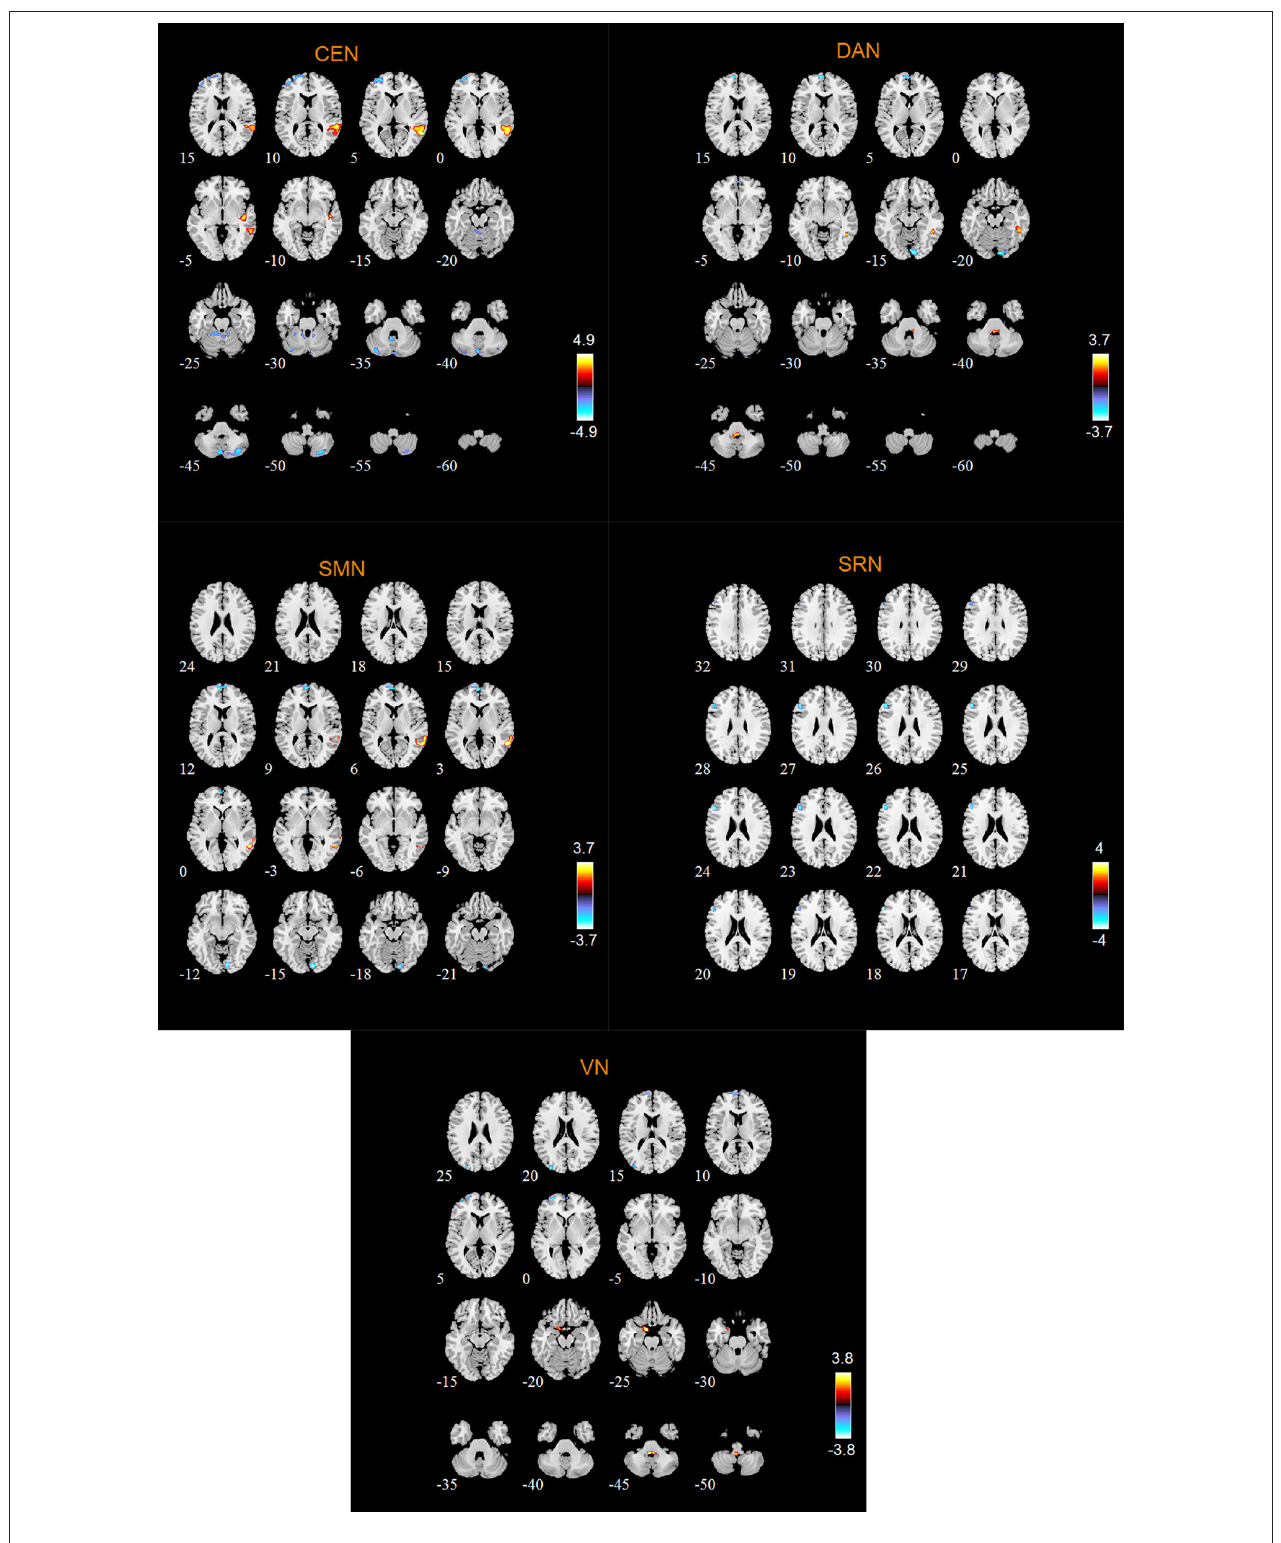
FIGURE 5 | Abnormal brain regions in